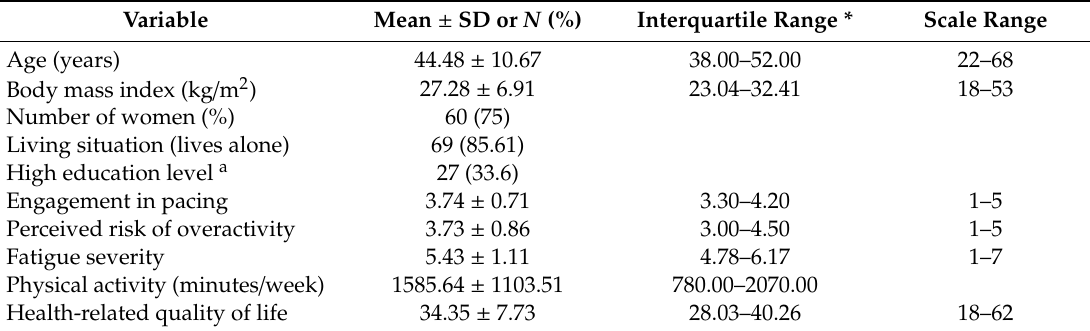
Table 1. Demographics of Participants ( N = 80).